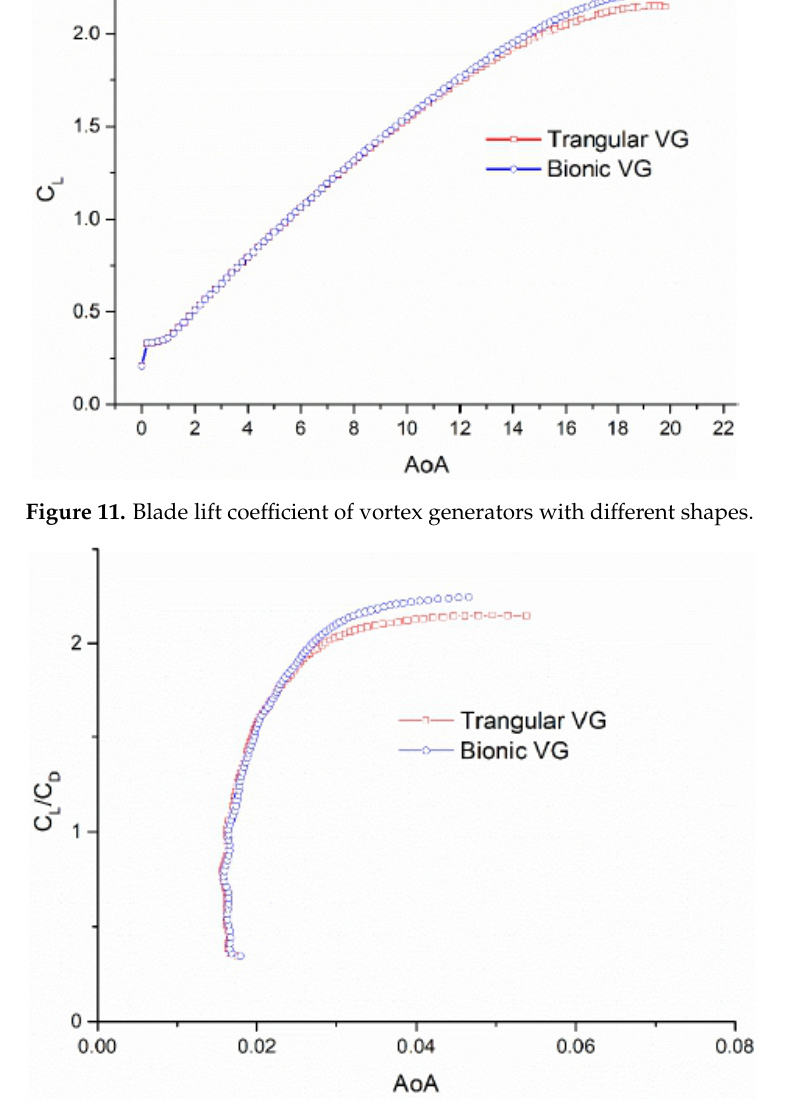
Figure 12. Blade pole curves of vortex generators with different